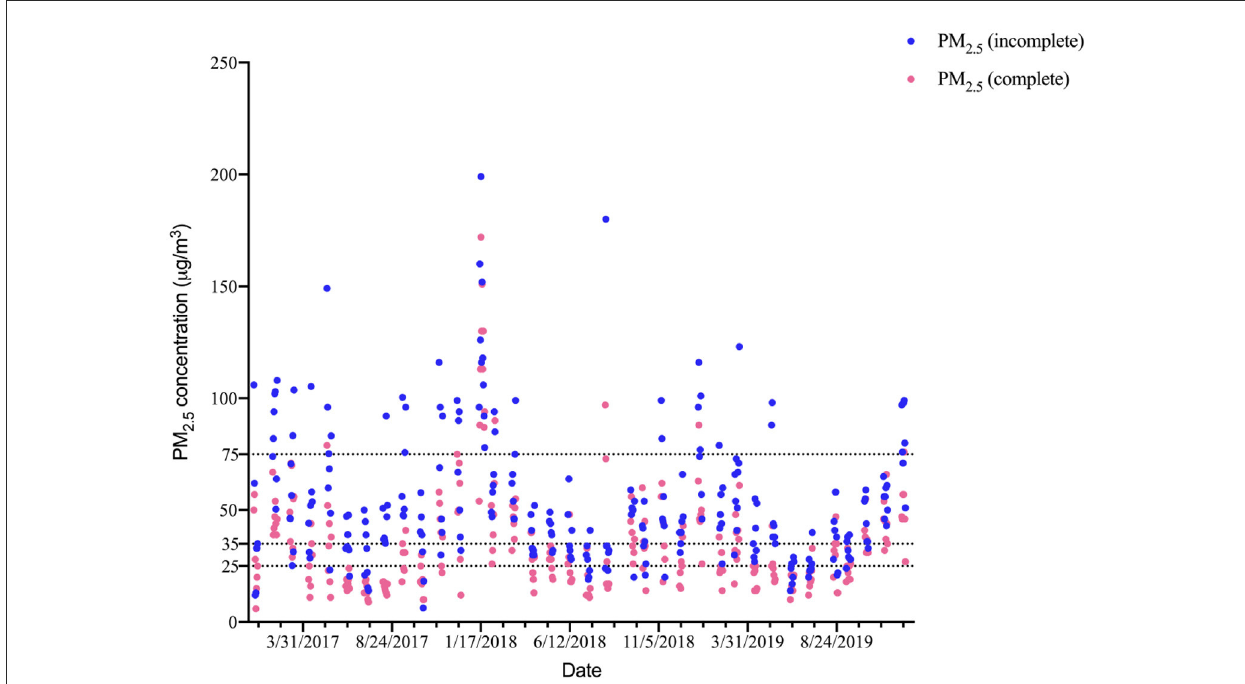
FIGURE1 Trends in the complete and incomplete PM 2.5 concentration ( µ g/m 3 ) on the sampling dates in Yuexiu district and a comparison with World Health Organization and GB 3085-2012 standards. The three lines represent PM 2.5 concentration limits in GB 3085-2012 (75.00 and 35.00 µ g/m 3 ) and World Health Organization (25.00 µ g/m 3 ).